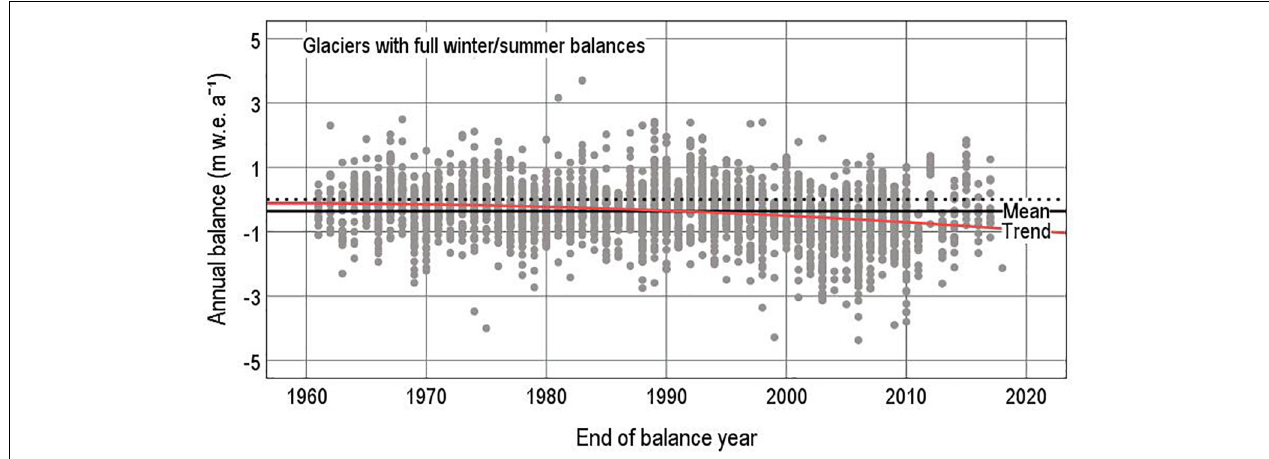
FIGURE 4 | Annual balances in the years 1961–2015 for glaciers with winter and summer balances. The solid black line denotes the mean value for all years, while the red curve denotes a quadratic year on year